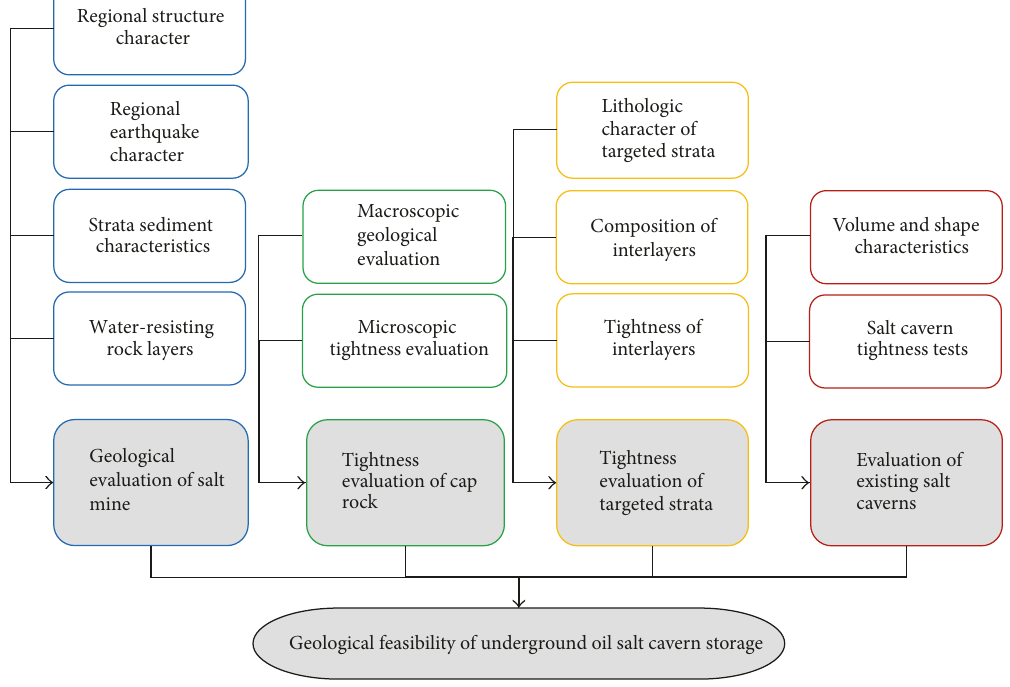
Figure 2: Evaluation system of geological feasibility on underground oil